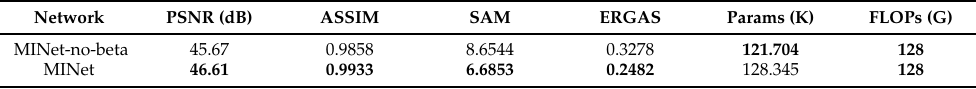
Table 6. Contrast effect of beta network in MINet. The best results are shown in